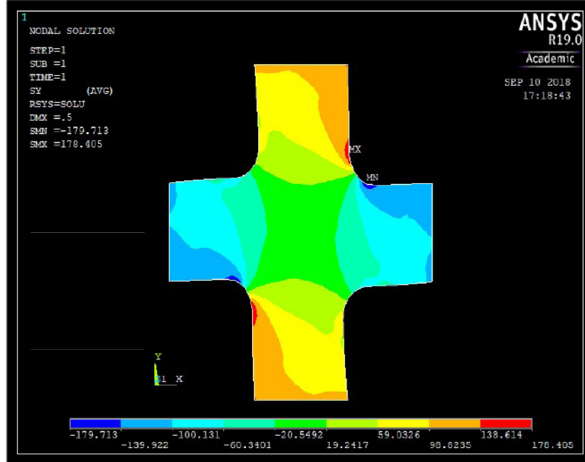
Figure 14: σ 22 contour plot in the cruciform